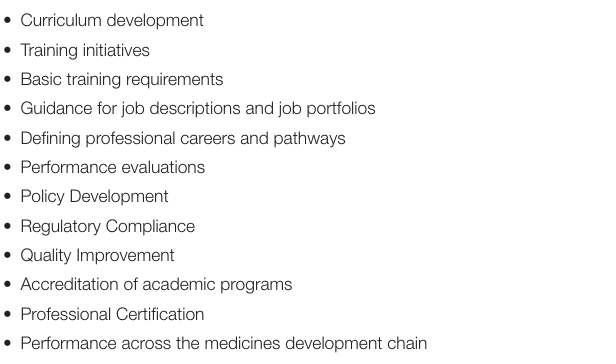
TABLE 2 | Potential Use of Professional Competencies in the creation of